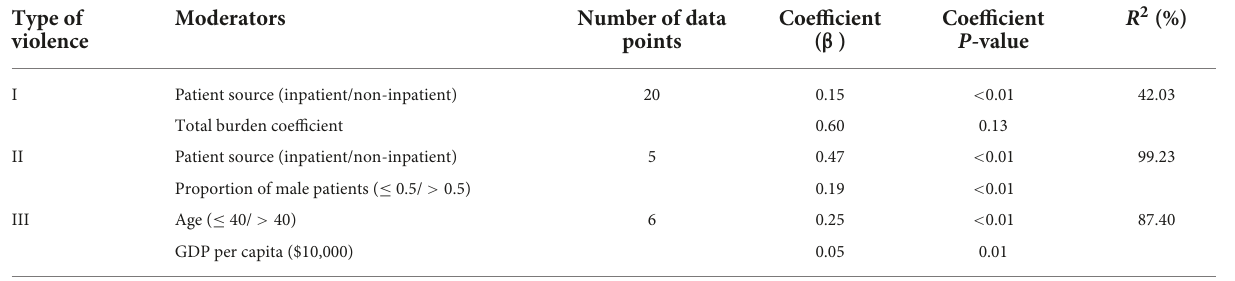
TABLE 3 The results of multivariate meta-regression analysis (high-quality